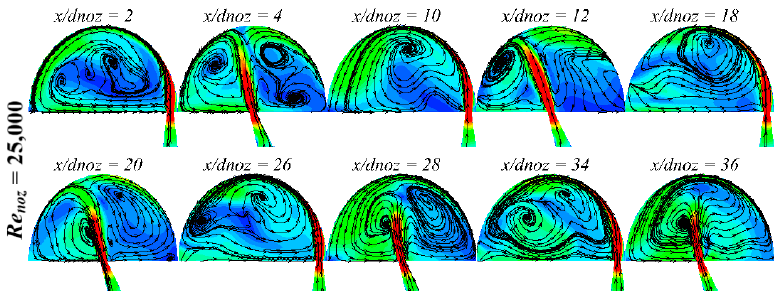
Figure 9. Area-average velocity contours with streamlines of the compound cooling unit at different x/d noz sections.